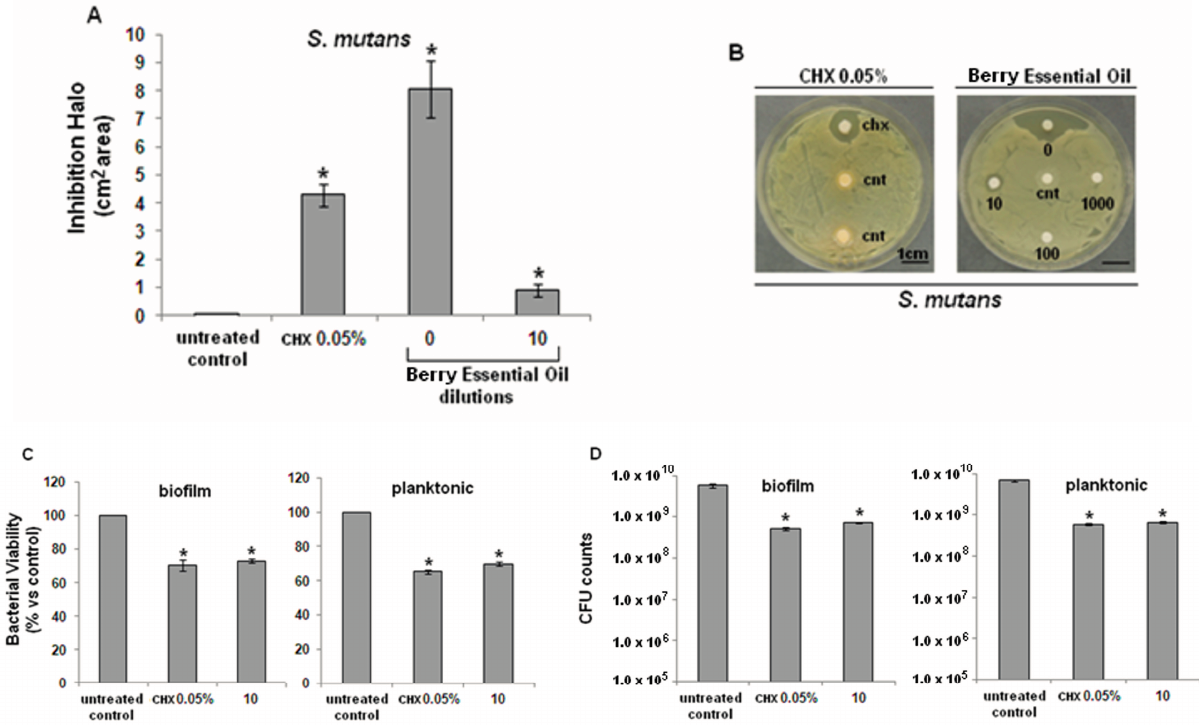
Figure 1. Antibacterial activity of J. excelsa EO against S. mutans . ( A ) Bacteria growth was inhibited by pure (0) or 1/10 diluted EO (10); inhibition was statistically significant in comparison with controls (cnt) ( p < 0.05, indicated by the * ); ( B ) higher EO dilutions (100 or 1000) were ineffective; ( C ) XTT assay revealed a similar activity between CHX and EO (10), statistically different from controls ( * p < 0.05) for both biofilm (left) and planktonic (right) cells; ( D ) CFUs counts showed that CHX and EO (10) determined a similar significant reduction of about 1.5 logs in comparison with control ( * p < 0.05) for both biofilm (left) or planktonic (right) cells. Data are expressed as mean ± standard deviation. Results from the metabolic bacterial assay (XTT) showed that EO significantly decreased the viability of S. mutans (Figure 1C) and A. actimomycetemcomitans (Figure 2C), both in their biofilm (left graphic) and planktonic (right graphic) forms, compared with untreated controls ( p < 0.05), similarly to CHX. Lastly, CFU counts of S. mutans (Figure 1D) and A. actimomycetemcomitans (Figure 2D), both in their biofilm (left graphic) and planktonic forms (right graphic) confirmed the data obtained with the XTT